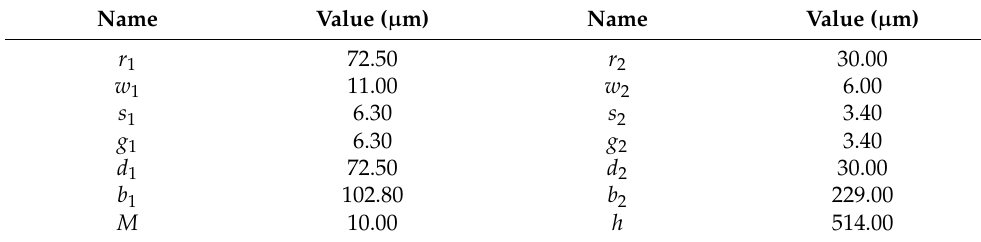
Table 2. Parameters of the optimized array dual-band antenna.